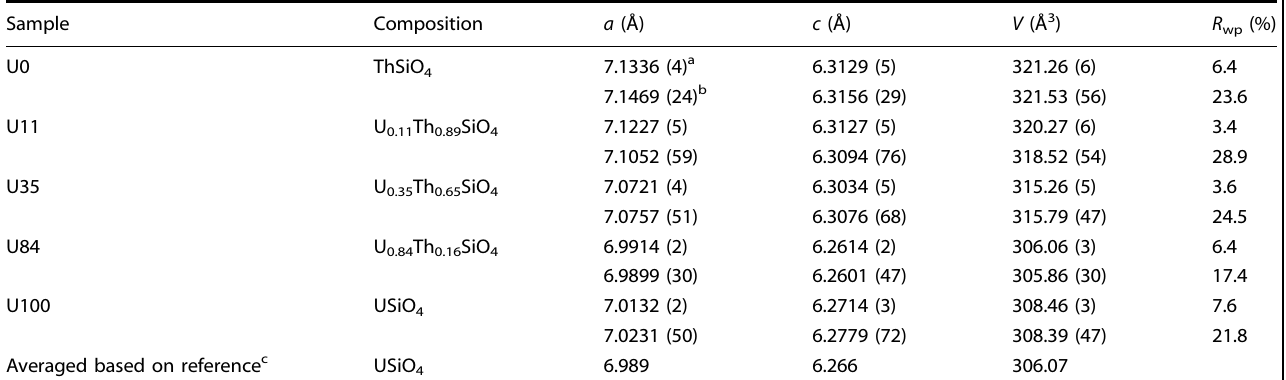
Table 1. Unit-cell parameters obtained from ND Rietveld re fi nement and PDFgui re fi nement. Sample